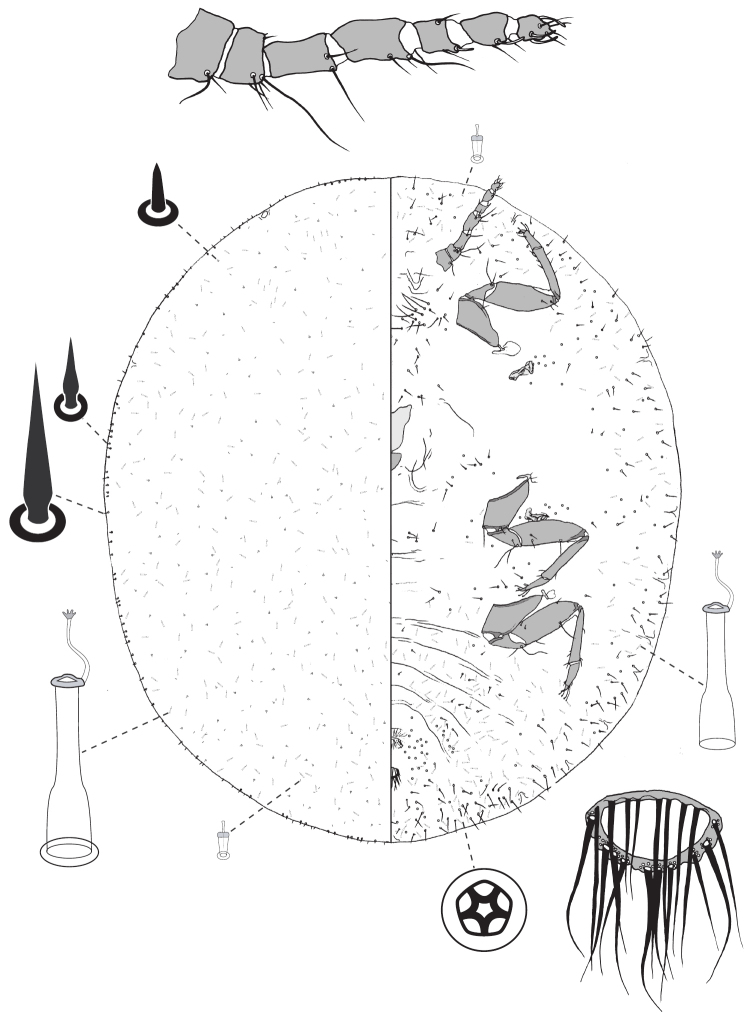
Adult female of Lachnodiuseucalypti (Maskell).